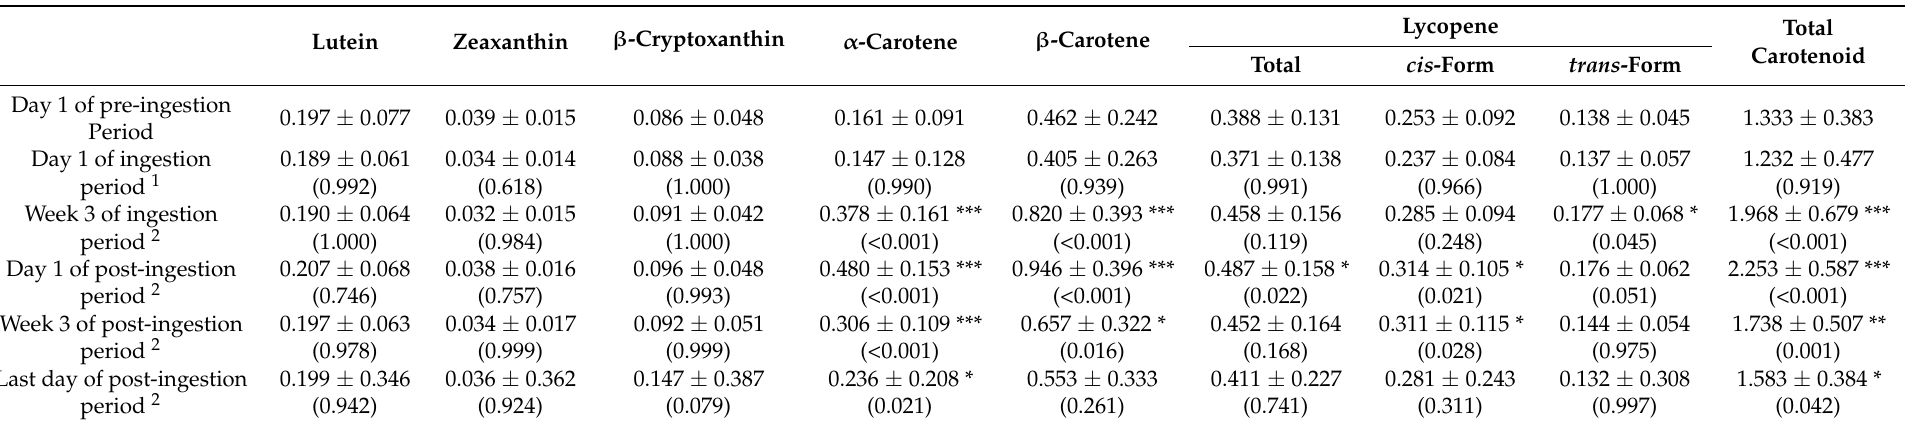
Table 1. Blood carotenoid concentration. Mean ± SD ( µ g/mL) and p value (in parentheses). Lutein Zeaxanthin β -Cryptoxanthin α -Carotene β -Carotene